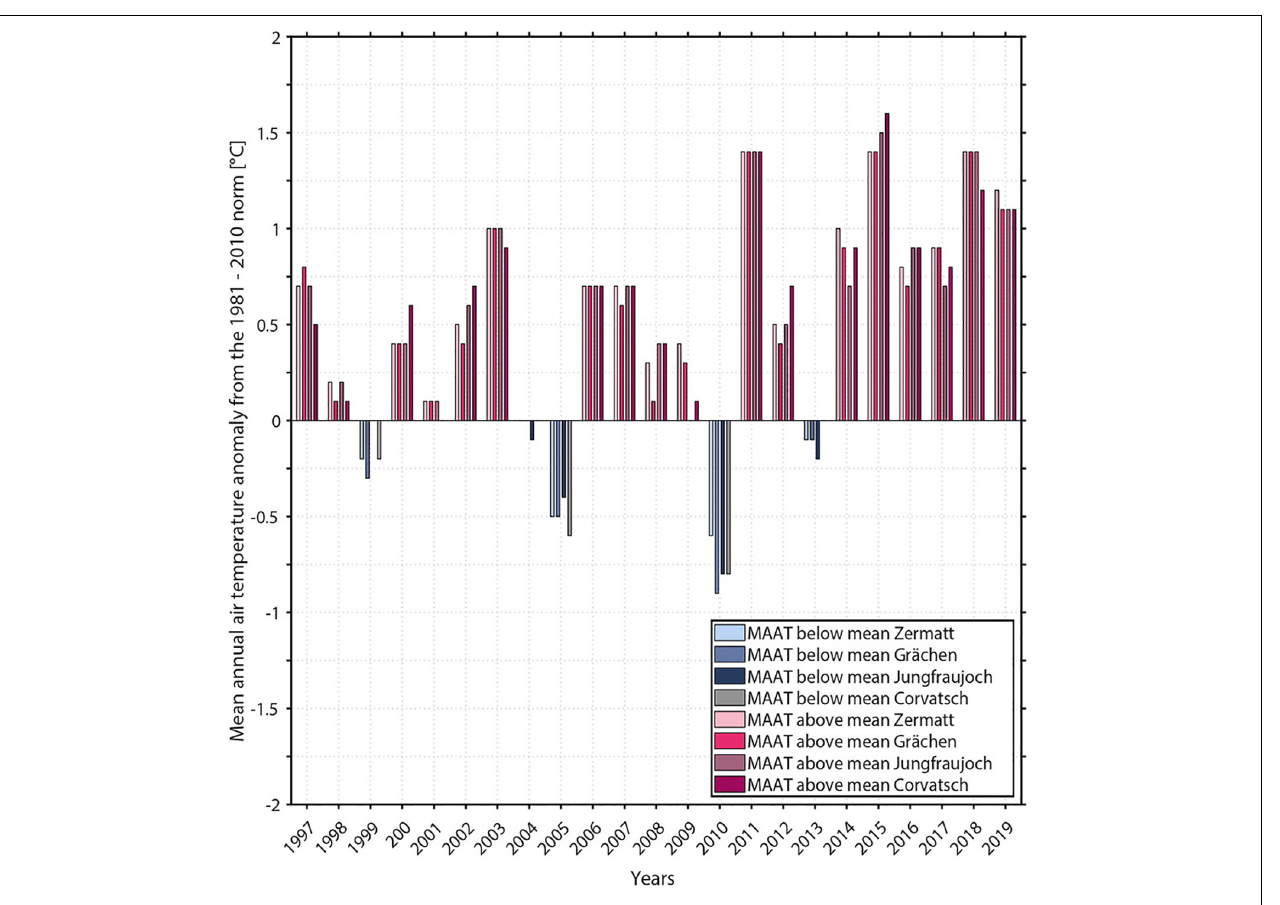
FIGURE 4 | Mean annual air temperature (MAAT) anomalies from the 1981–2010 norm based on homogenised data series from the MeteoSwiss automatic weather stations Jungfraujoch, Piz Corvatsch, Grächen, and Zermatt. All reddish bars show temperatures above and all bluish bars below the respective climate station